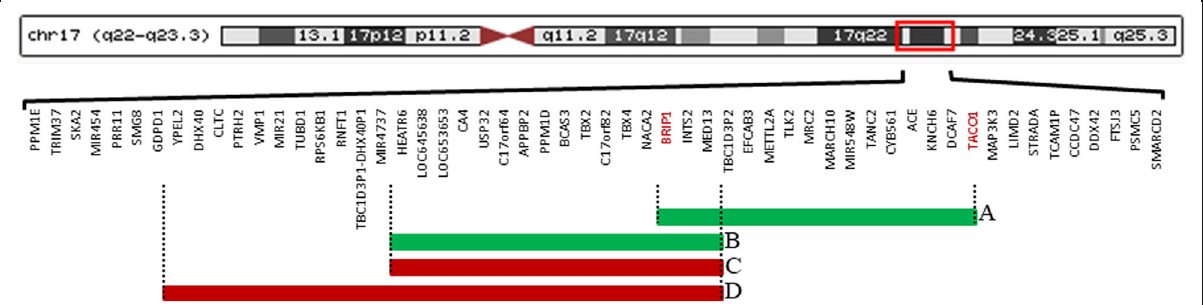
Fig. 1 Diagram depicting the organization of genes in the 17q23 regions and the genomic arrangements involved within region. The structure of this region has been simplified for illustrative purposes. A: The 2 Mb duplication at 17q23.2q23.3 in the child described in this report. B: The 2.2 Mb 17q23.1q23.2 duplication in families described by Alvarado and colleagues [6]. This duplication was associated with clubfoot, mild short stature, and other skeletal abnormalities [6]. C: The 2.2 Mb 17q23.1q23.2 deletion in patients 1, 3, 4, 5, 6, and 7 described by Ballif and